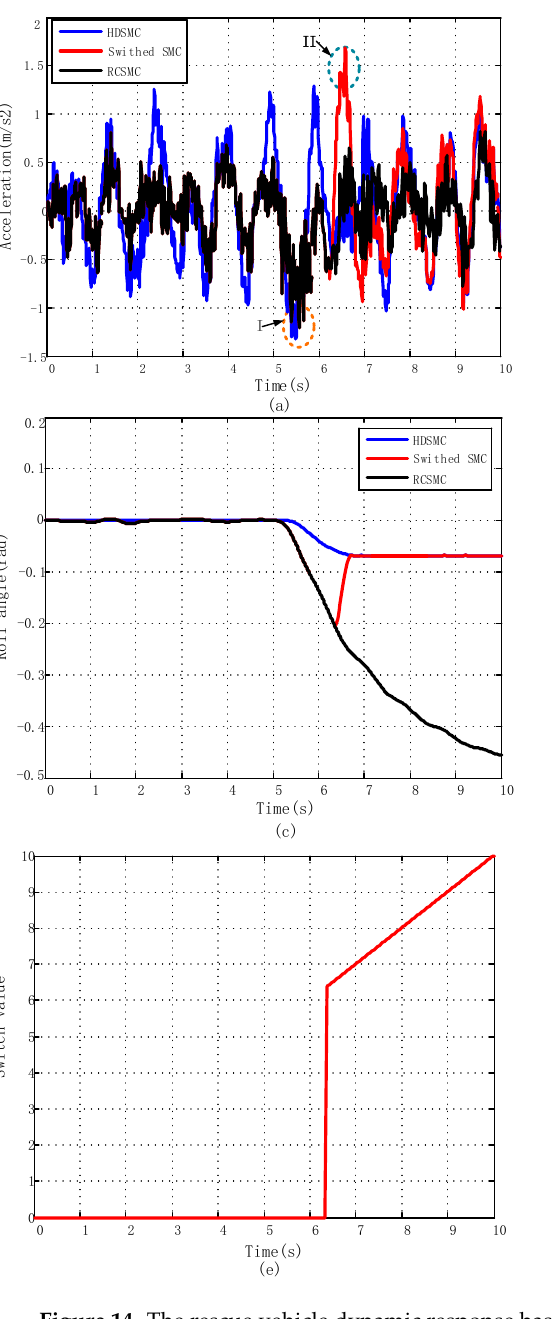
Figure 13. The input signals of vehicle: ( a ) the random road; ( b ) the steering angle under J-turn maneuver.